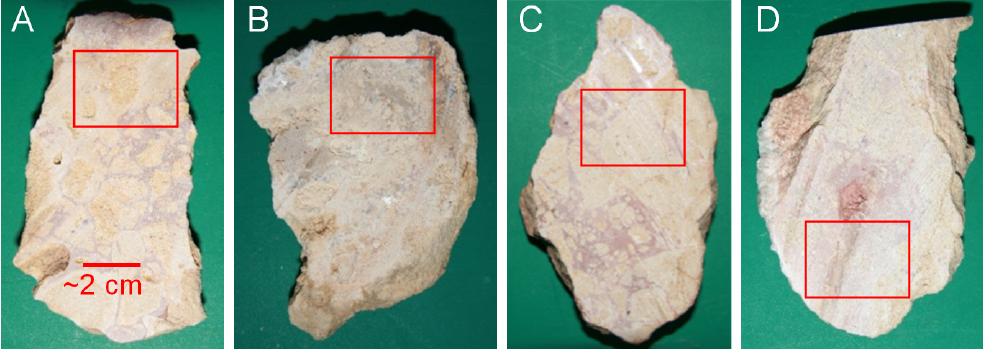
Figure 2. Fresh surfaces of carbonate rock samples, with red rectangles pointing out areas of selected SisuCHEMA images.